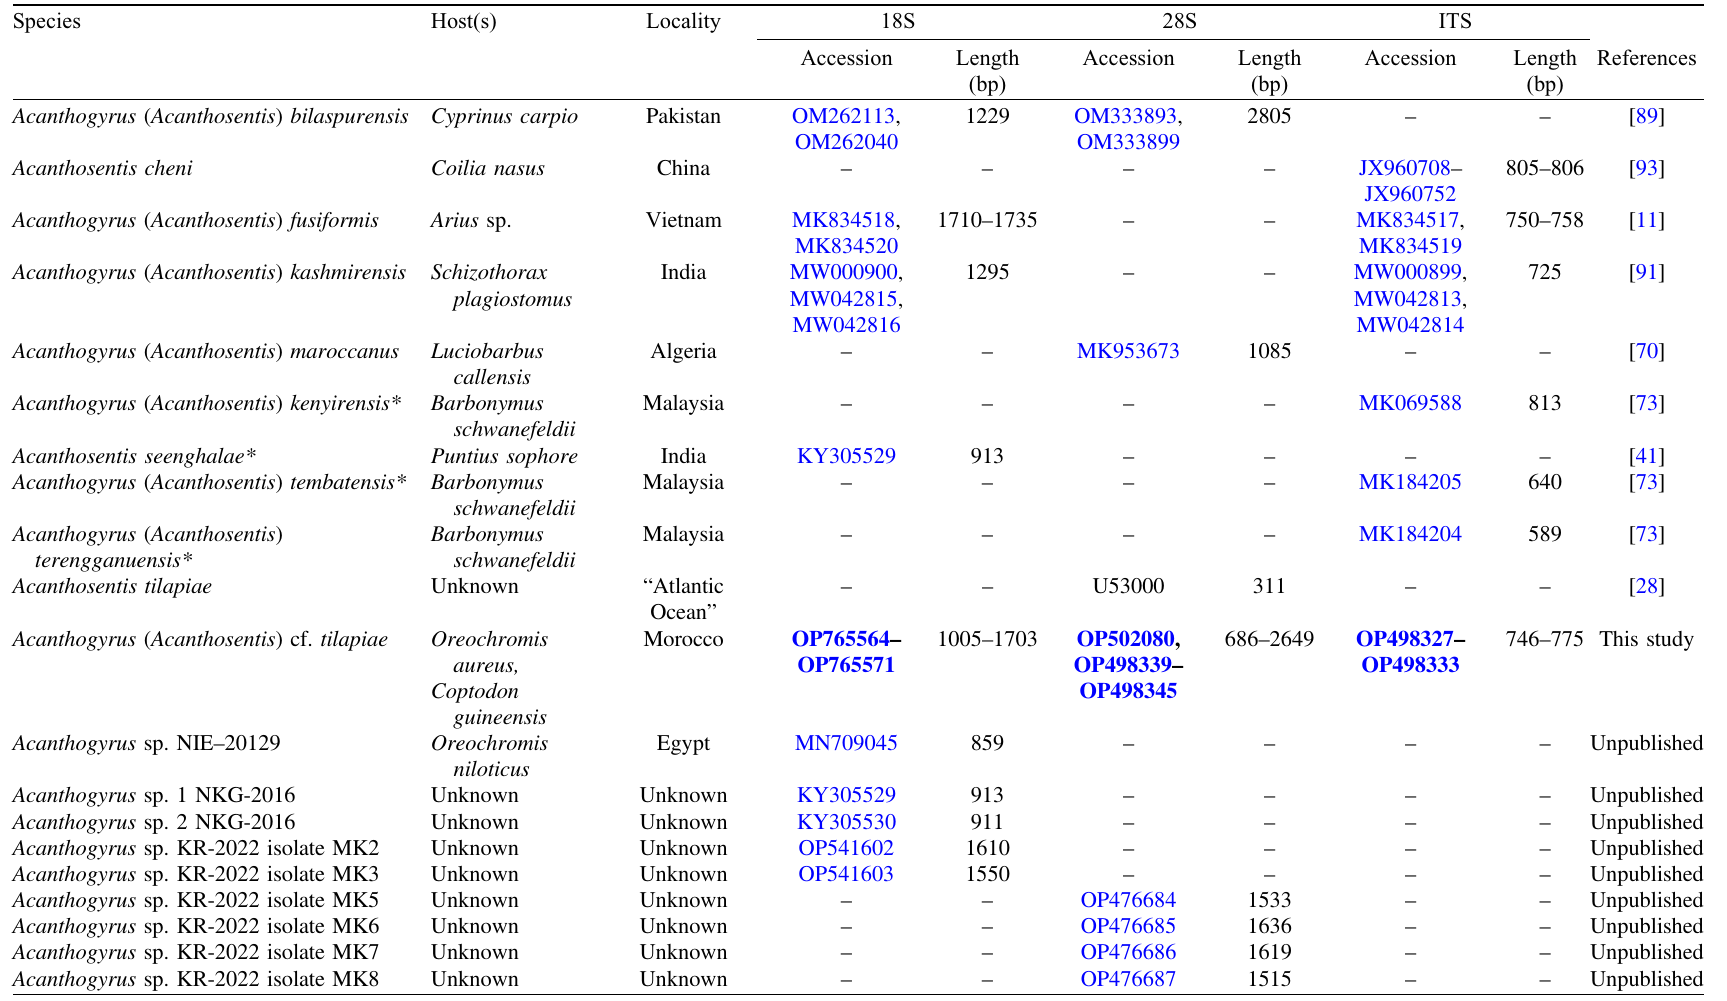
Table 1. Acanthogyrus ( Acanthosentis ) species and sequences used in this study, including host(s), locality, GenBank accession numbers, and sequence lengths. If only one sequence length is listed for multiple accession numbers, the sequences are the same number of base pairs; otherwise, ranges are reported. Accession numbers in bold are from this study. There are mitochondrial cytochrome c oxidase I (mtCOI) sequences in GenBank for Acanthogyrus cheni (KX108947) and A. kenyirensis (MN833316), but our efforts to amplify mtCOI for A. ( A. ) cf. tilapiae were unsuccessful. *As of this submission, the species names were not updated in GenBank. 28S = large subunit ribosomal RNA (rRNA) gene, 18S = small subunit rRNA gene, ITS = the internal transcribed spacer region of the rRNA